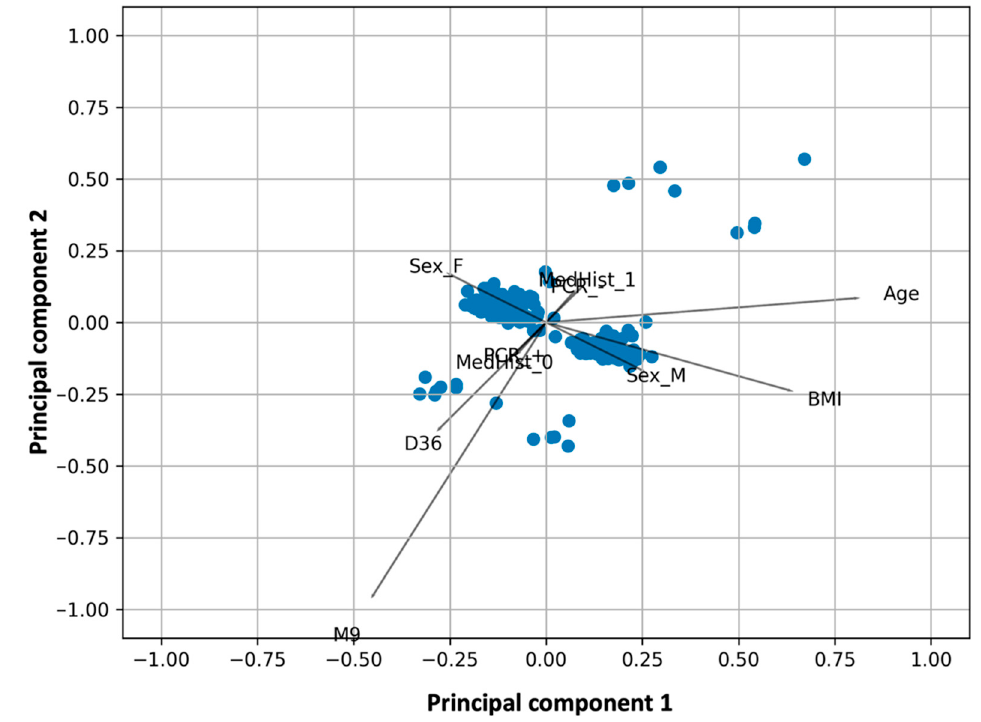
Figure 3. Biplot for factor analysis of mixed data. The coordinates of the two-dimensional plot refer to the “scores” of the variables in the dimensionality-reduced space (two principal components are shown in the plot). The lines represent the vectors of the variables in the 2D space. Key : D36, neutralizing antibody levels two weeks after second vaccination; M9, neutralizing antibody levels nine months after second vaccination; BMI, body mass index; MedHist_1, subjects with autoimmune disorders; MedHist_0, subjects without autoimmune disorders; Sex_M, men; Sex_F, women; PCR+, subjects with previous COVID-19 infection; PCR-, subjects without previous COVID19 infection.